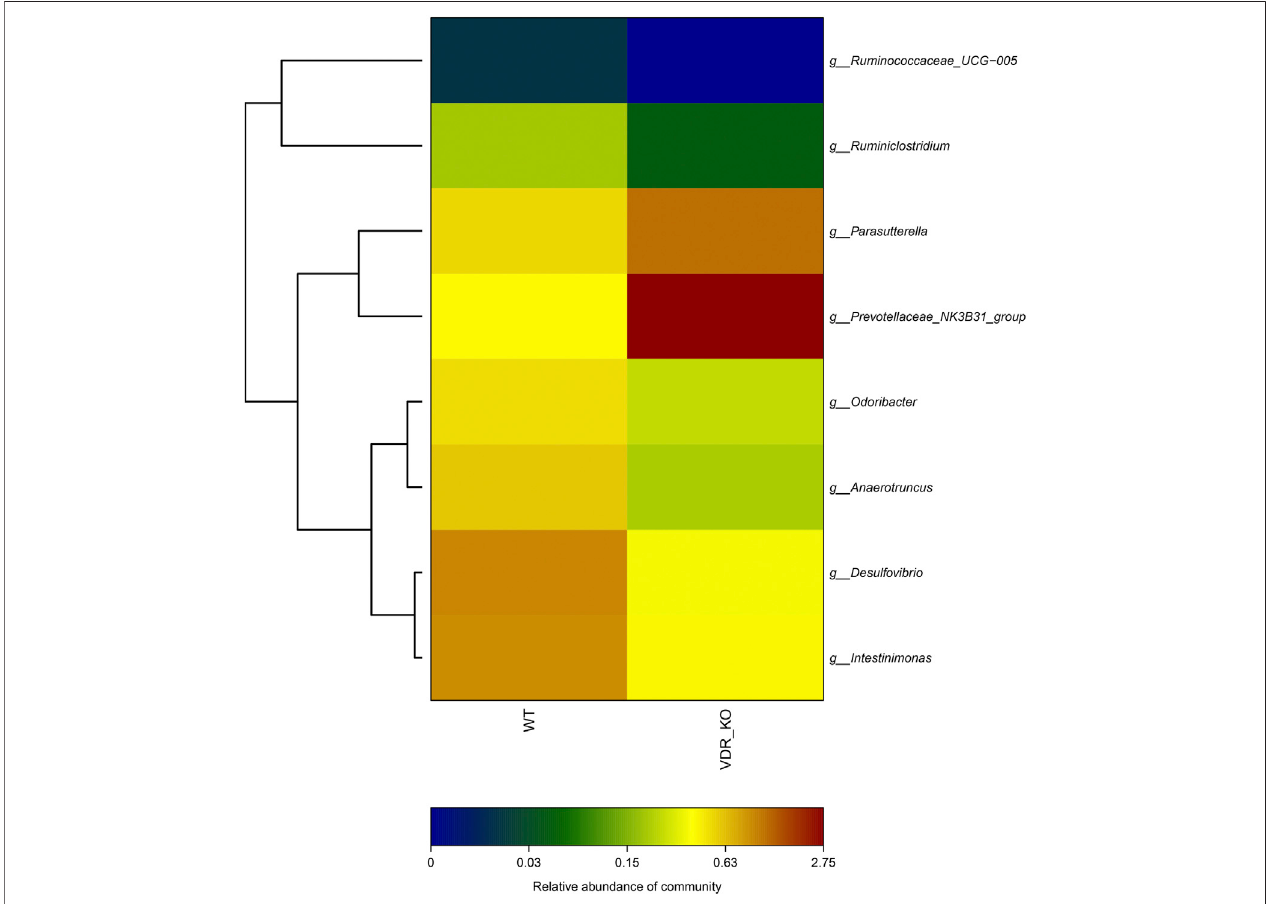
FIGURE6| 16SAnalysisofVDR-KOmousefecal fl ora.showedthespeciesandrelativedifferenceofwild-typecontrolgroup( n =5)andVDR-KOgroup( n =5).The colorofthesquarere fl ectstherelativecontentofaspeci fi cgenusinthefecal fl ora.Redrepresentshighabundance,whileclosertodarkbluerepresentslessabundance.